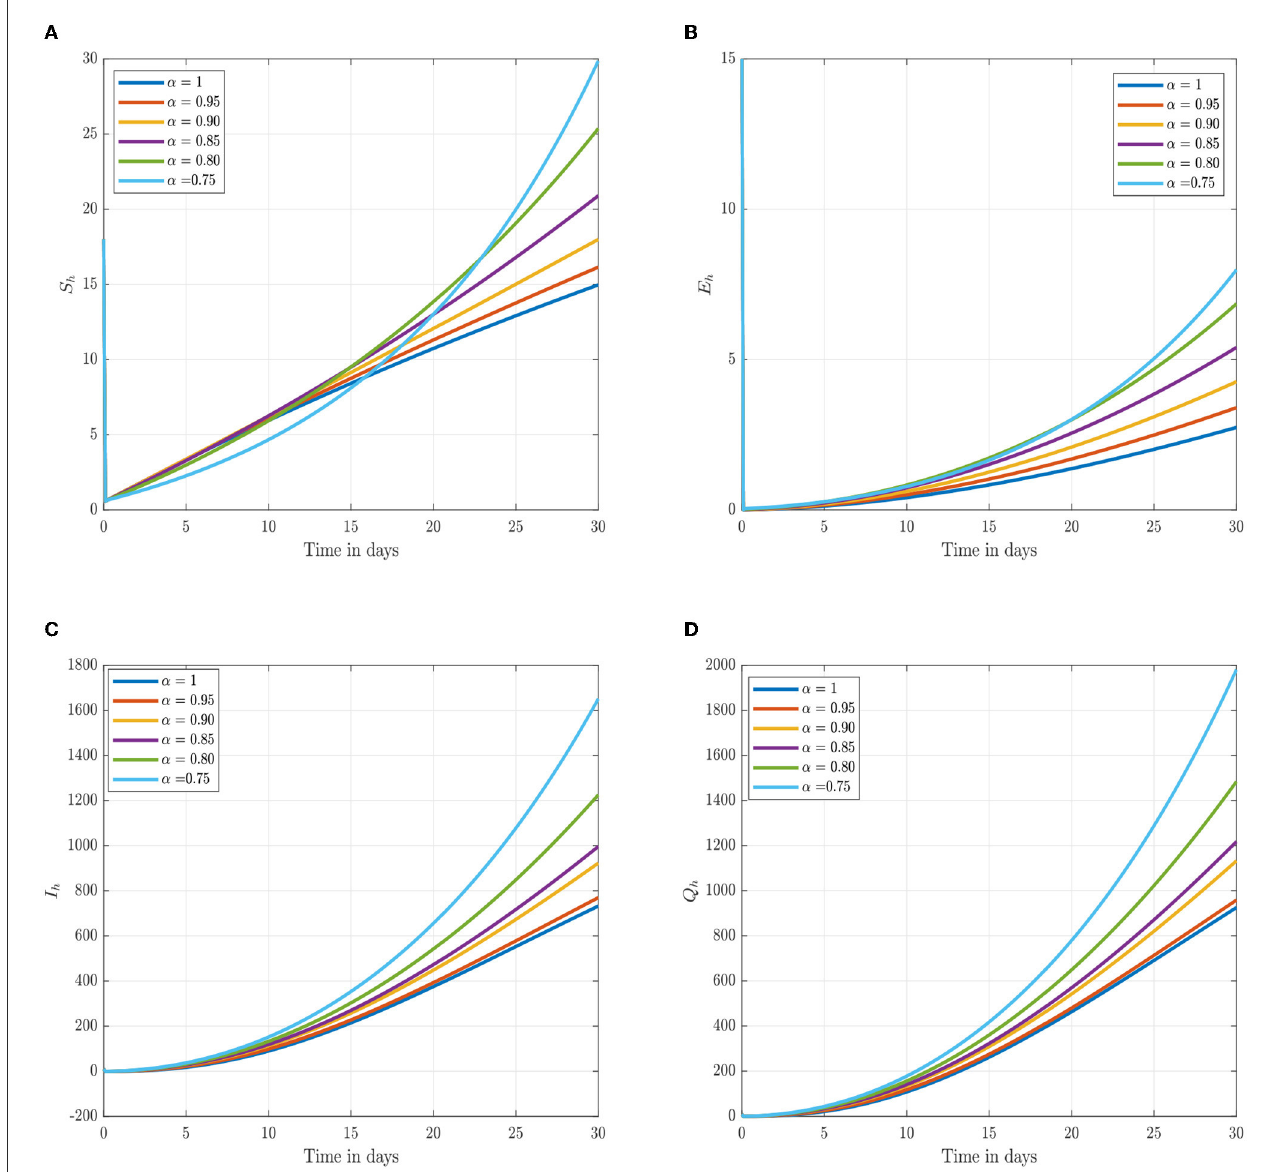
FIGURE4 Numerical trajectory of the CF-fractional-order derivative, α , of Equation (2). (A) Dynamics of susceptible ( S h ) humans class. (B) Dynamics of expose ( E h ) humans class. (C) Dynamics of infected ( I h ) humans class. (D) Dynamics of quarantine ( Q h ) class.